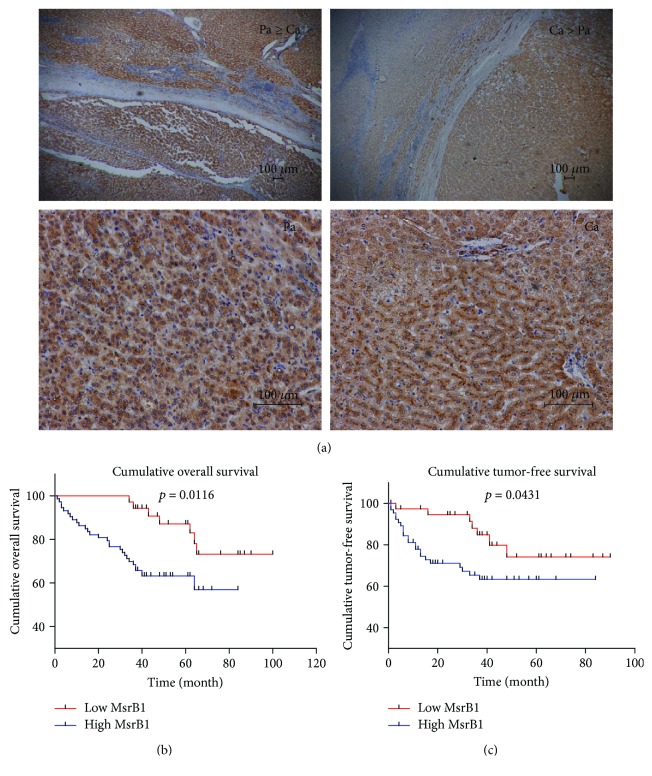
Tissue expression of MsrB1 in HCC and its relation to survival in survival analysis. (a) MsrB1 expression level is upregulated in carcinoma (Ca) and/or paratumor (Pa) tissue. (b) Compared with patients with low expression, patients with high MsrB1 expression had worse overall survival (P = 0.0116). (c) Compared with patients with low expression, patients with high MsrB1 expression had worse tumor-free survival (P = 0.0431).